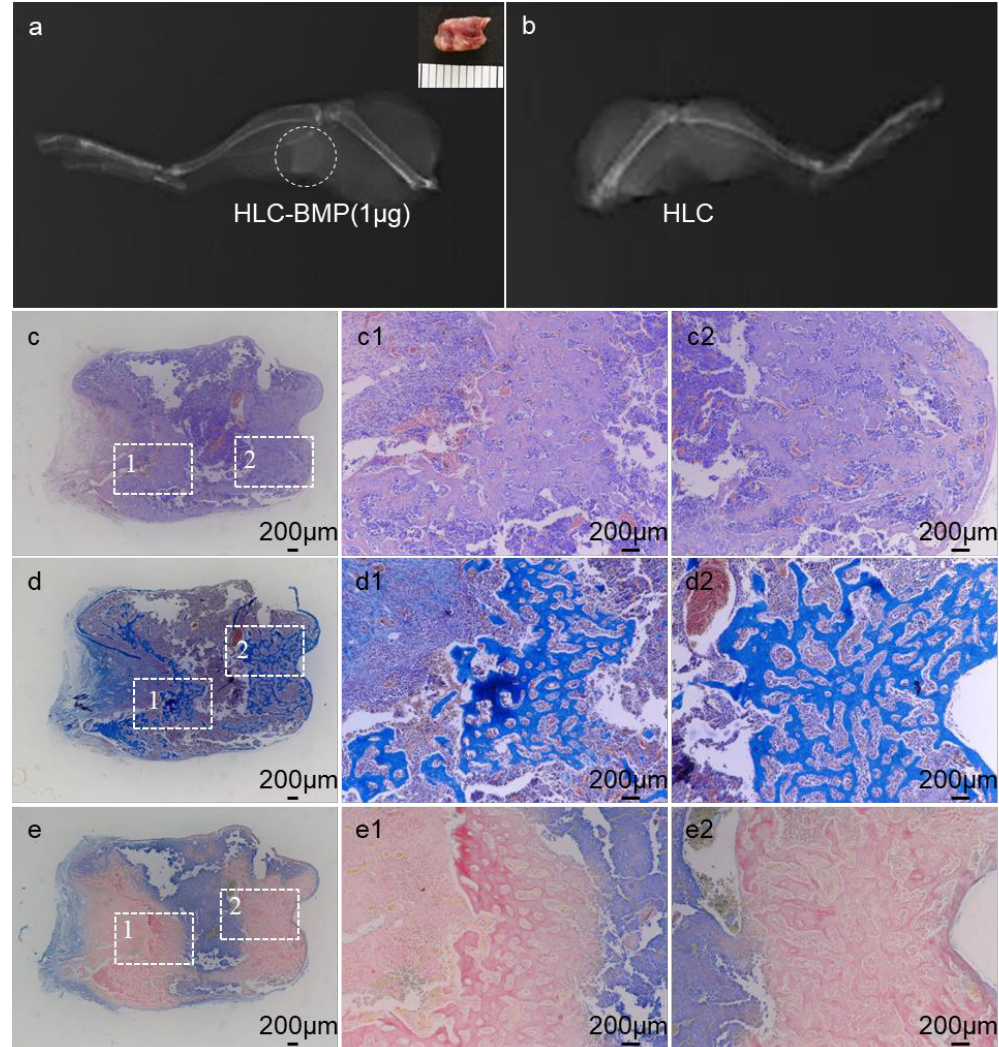
Figure 5. In vivo implantation of HLC-BMP sponges into muscle pouches of the mouse hind limb. ( a ) X-ray micrographs of new bone formation with the use of HLC sponge in 1 µg rhBMP-2 treatment groups at 4 weeks post-implantation. There is nothing formed in the HLC sponge group ( b ). Histological staining of the specimen with ( c ) H&E, ( d ) MTS, and ( e ) Ponceau’s stain, for HLC-BMP after implanted for 4 weeks, respectively.